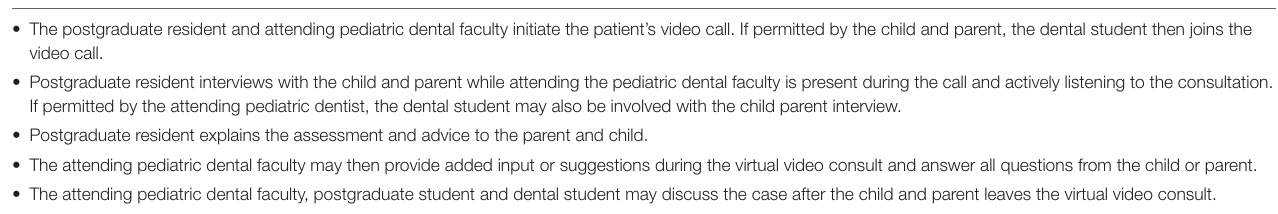
TABLE 2 | Suggested guidelines for encouraging dental student (undergraduate and postgraduate) participation in virtual consultations in pediatric